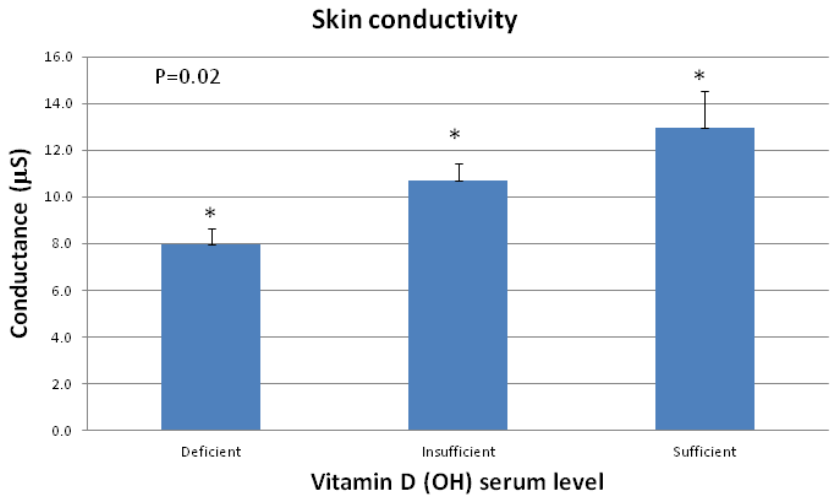
Figure 1. Subjects were categorized by their vitamin D (OH) serum levels. A statistically significant (ANOVA, p < 0.05) effect of serum 25(OH)D levels and skin conductance was observed. As serum 25(OH)D levels increased, skin conductance also increased.